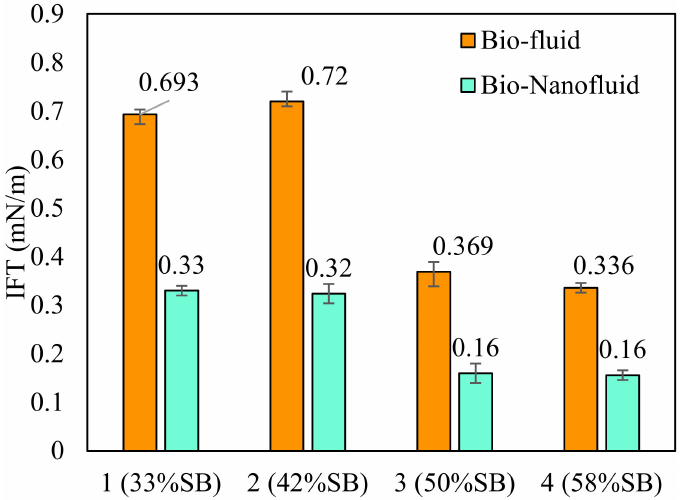
Figure 11. Interfacial tension measurements for combinations of SB/AGC:bio-ethanol at proportions of SB at 33, 42, 50, and 58% v · v − 1 in the presence and absence of SiO 2 -RH nanoparticles at 100 mg · L − 1 . Measurements at reservoir temperature (47 ◦ C) by spinning drop equipment. The standard deviation is represented by error